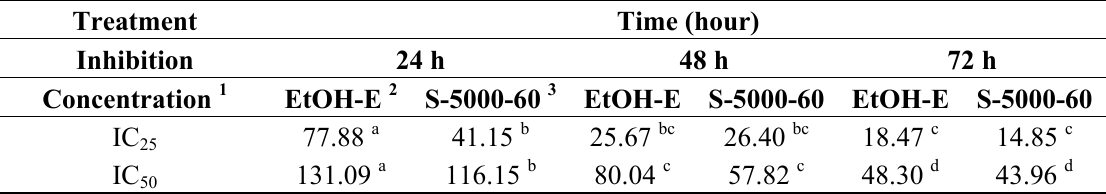
Table 4. Anti-proliferation effects of supercritical fluid and ethanolic extracts of solid-cultured